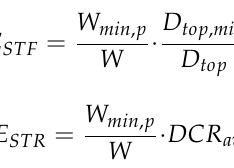
stiffness and strength, are suggested in Equations (8) and (9),